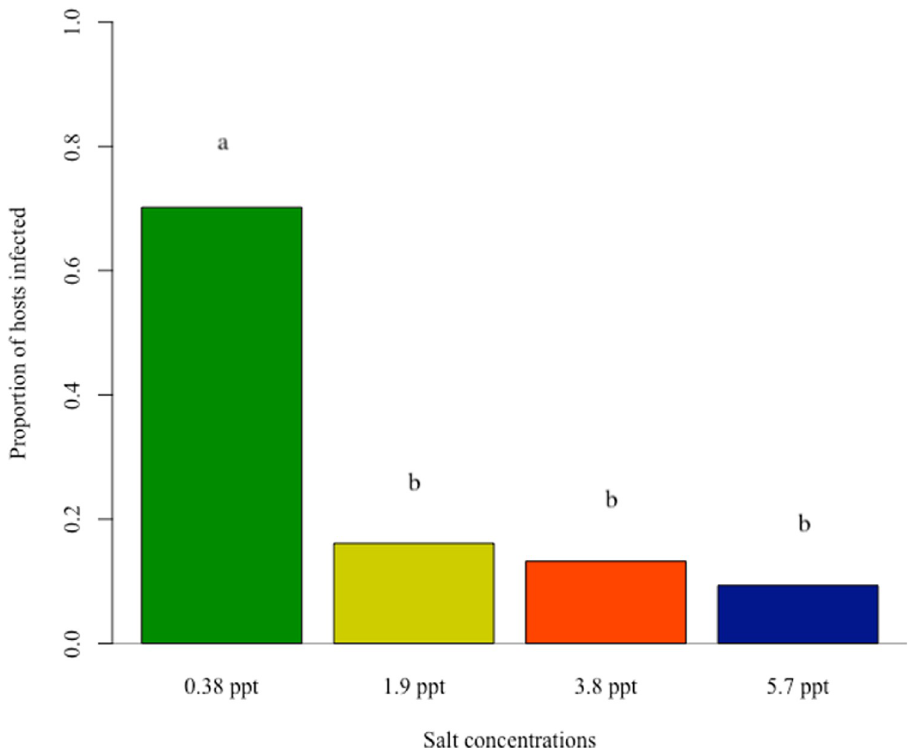
Fig 3. Snail infection prevalence in 0.38 ppt, 1.9 ppt, 3.8 ppt, and 5.7 ppt salinity treatments after exposure to Schistosoma mansoni miracidia. Different letters above bars indicate significant differences in infection prevalence among the treatments. For pairwise comparisons see supplement Table E in S1 Text .